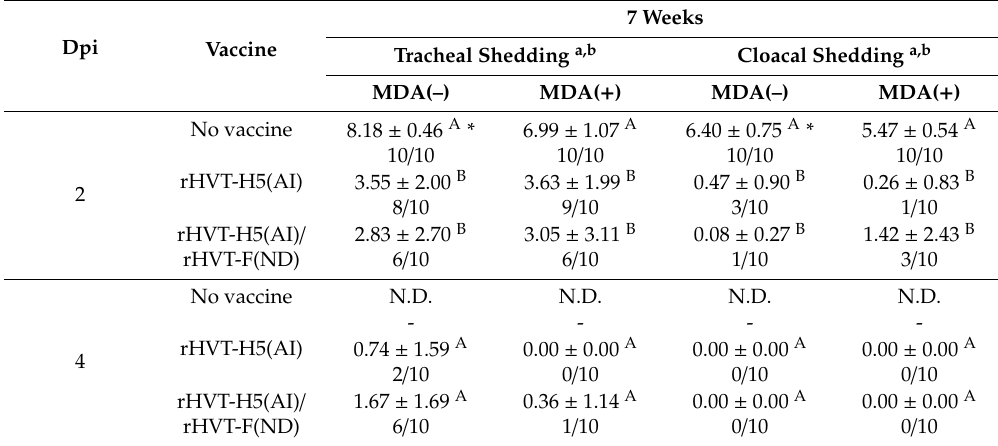
Table 6. Tracheal and cloacal shedding of H5-HPAIV after challenge at 7 weeks of age with H5-HPAIV to LBL layer chickens (experiment II) vaccinated at day-old with rHVT-F(ND), rHVT-H5(AI), or both